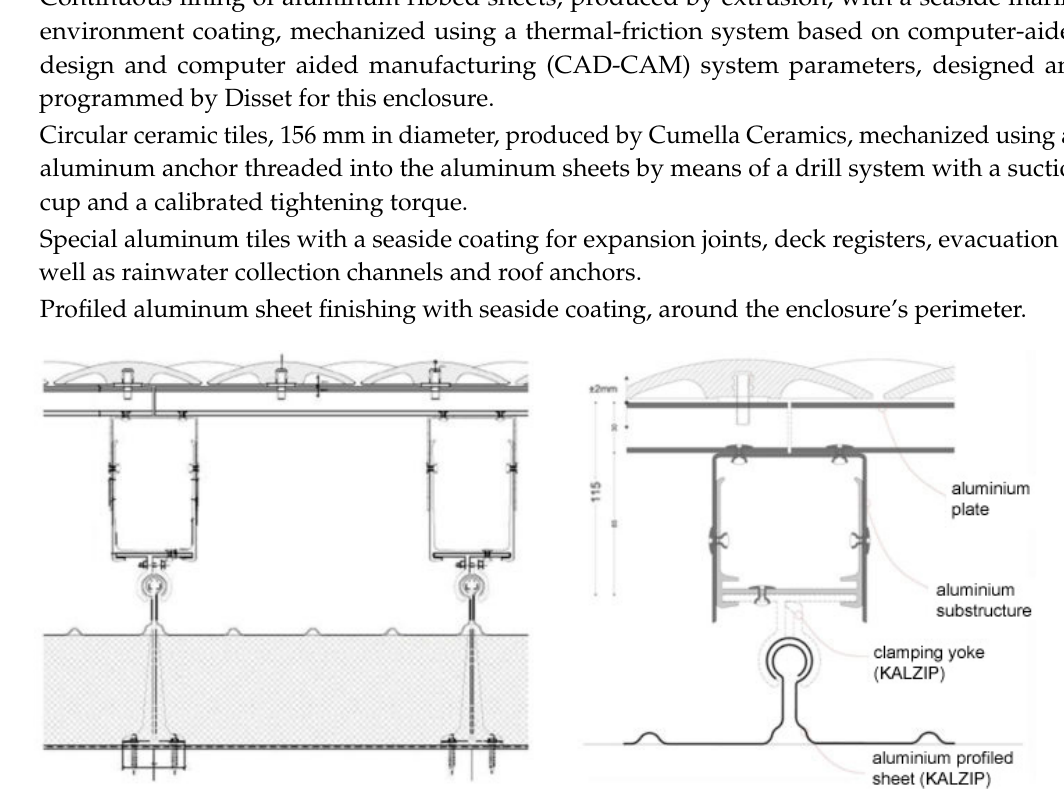
Figure 2. Construction details of the enclosure and the laying of the ceramic tiles. Tectónica. RPBW. Disset. http://tectonicablog.com/wp-content/uploads/2017/03/20-730 × 316.jpg. Appl. Sci. 2019 , 9 , x